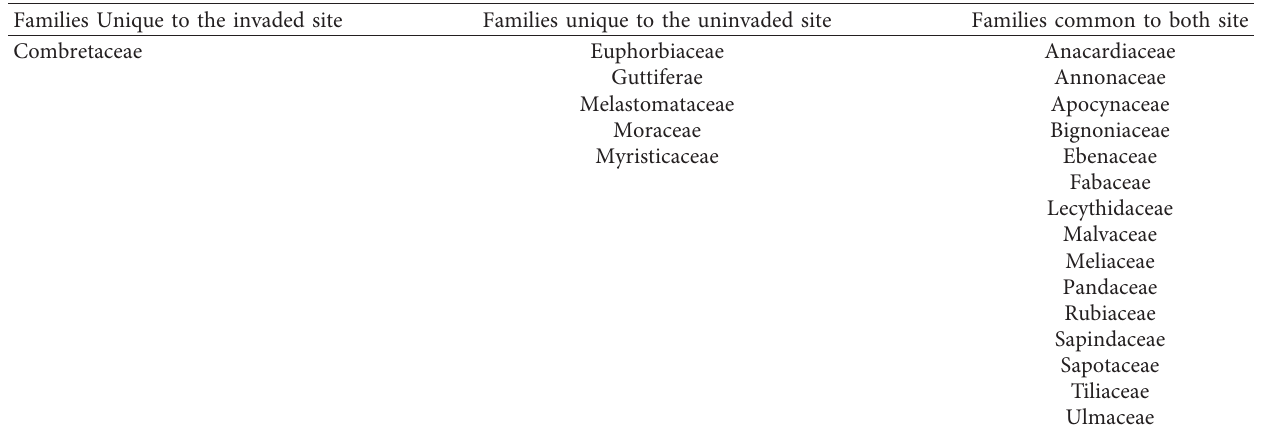
Table 4: Family distribution of species on the study sites.